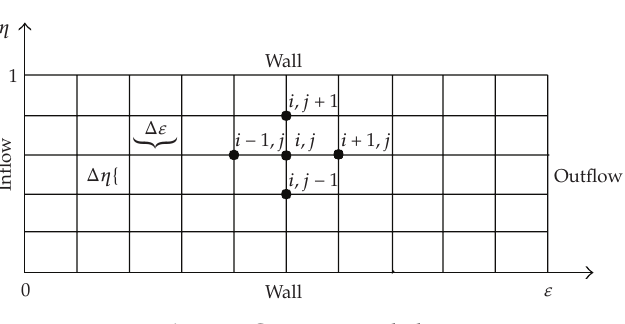
Figure 4: Computational